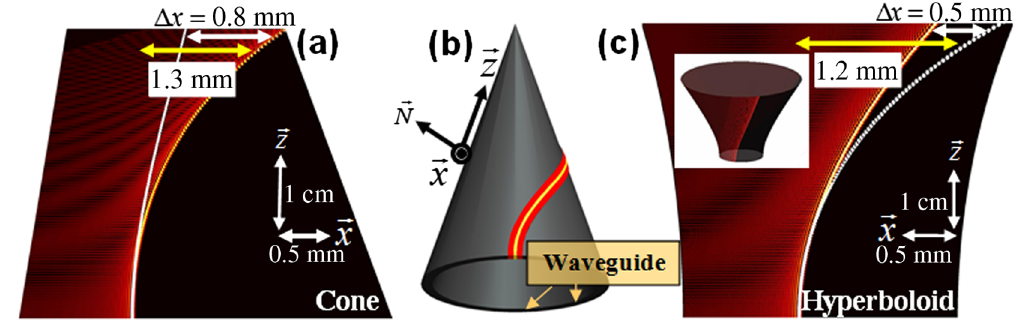
FIG. 1. (b) Sketch of a surface of revolution (cone). The EM field is restricted to propagate within the surface area by a thin waveguide layer. (a) – (c) The evolution of the envelope of an accelerating beam ( ψ ) on the surface area of a cone (a) and of an hyperboloid (both with 10-cm height, 3-mm base radius, and a propagation constant of 1 . 2 e 7 m − 1 ). (c) The dashed white line displays the propagation of the same beam in flat space, projected on the surface of revolution. The beam apertures are (a) 9 mm and (c) 6 mm, with main lobes of widths of (a) 30 μ m and (c) 33 μ